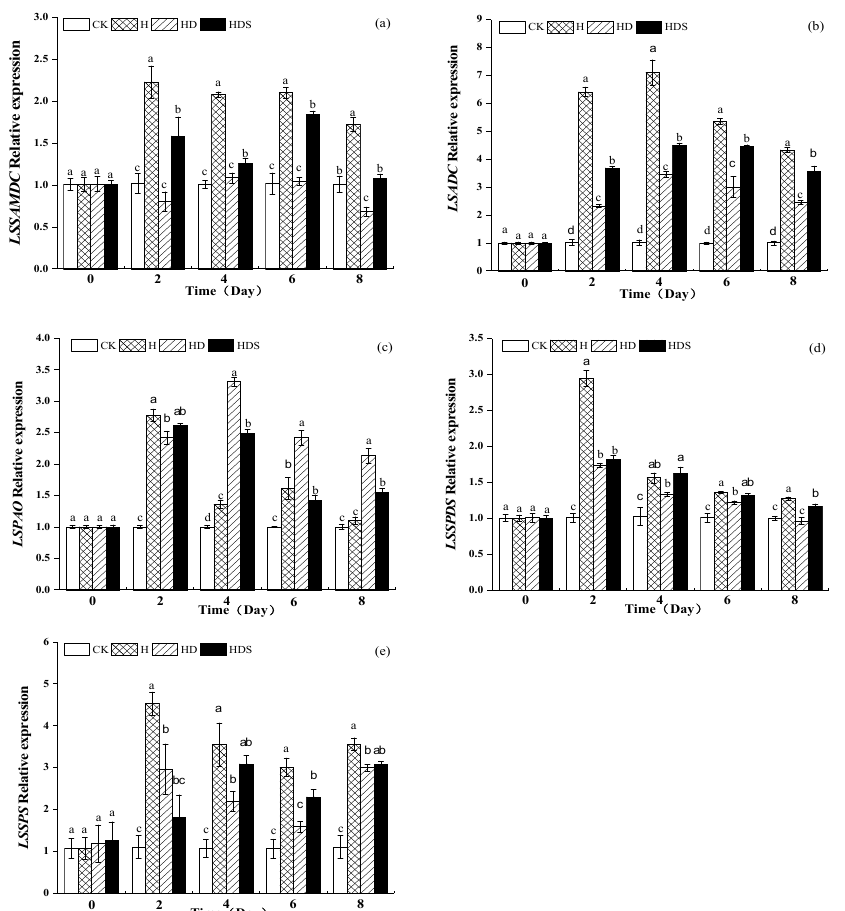
Figure 8. Expression levels of lettuce LsSAMDC ( a ), LsADC ( b ), LsPAO ( c ), LsSPDS ( d ), and LsSPS ( e ) genes under high-temperature stress. Vertical bars represent standard deviations of the mean ( n = 3). Values above each vertical bar followed by different letters show significant differences ( p < 0.05). CK, 22 ◦ C/17 ◦ C, deionized water; H, 35 ◦ C/30 ◦ C, deionized water; HD, 35 ◦ C/30 ◦ C, 1 mM D-arg; HDS, 1 mM D-arg+ 1 mM Spd.